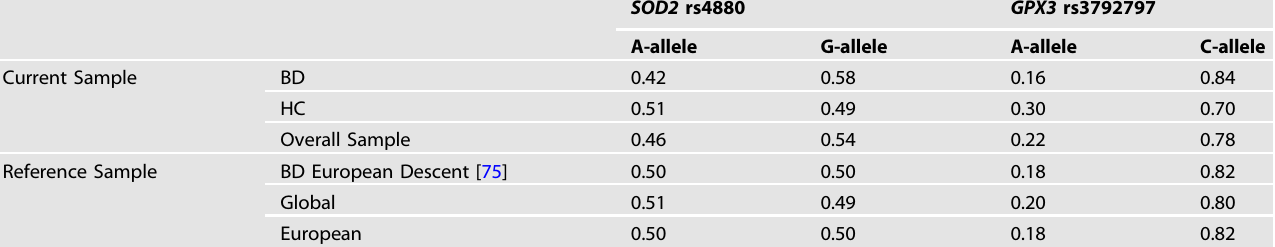
Table 1. Allele frequencies for SOD2 rs4880 and GPX3